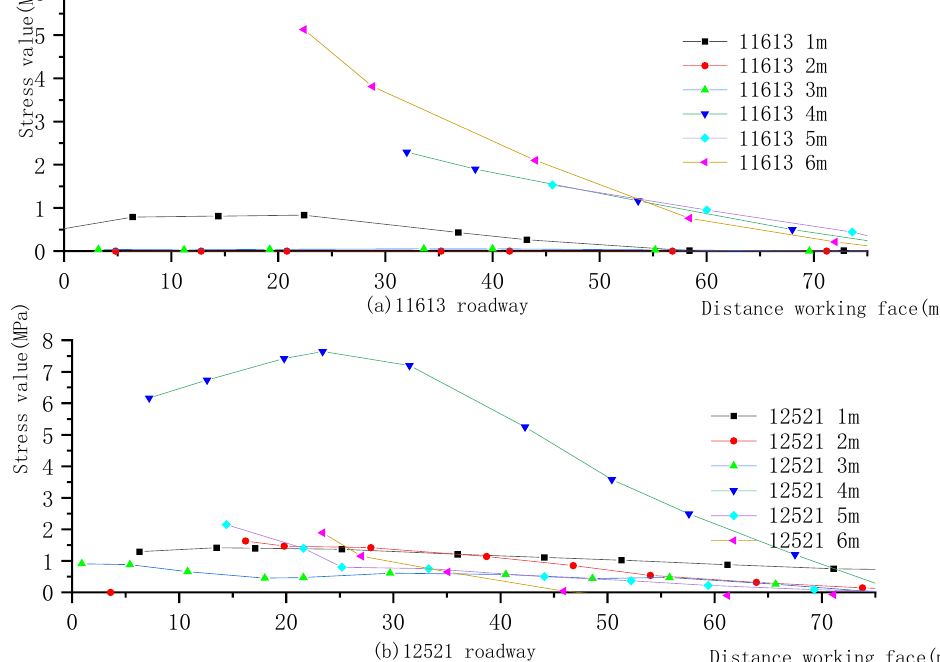
Figure 14. Comparison analysis diagram of high lateral stress. ( a ) 11613 roadway; ( b ) 12521 roadway.